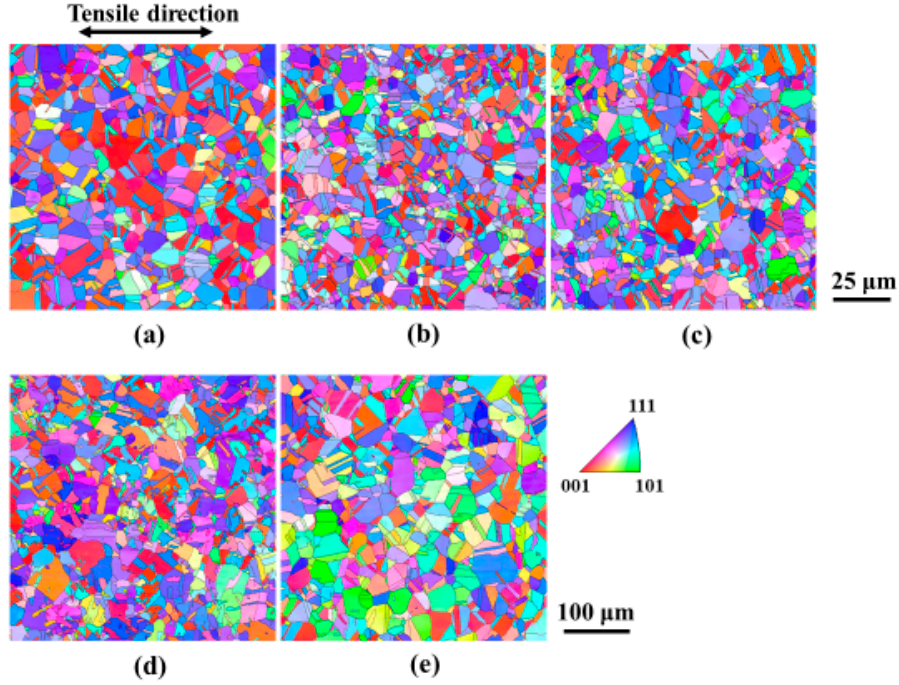
Figure 13. IPF maps for ( a ) Cu-2Mg, ( b ) Cu-2Sn, ( c ) Cu-2Si, ( d ) Cu, and ( e ) Cu-10Zn specimens before tensile deformation.